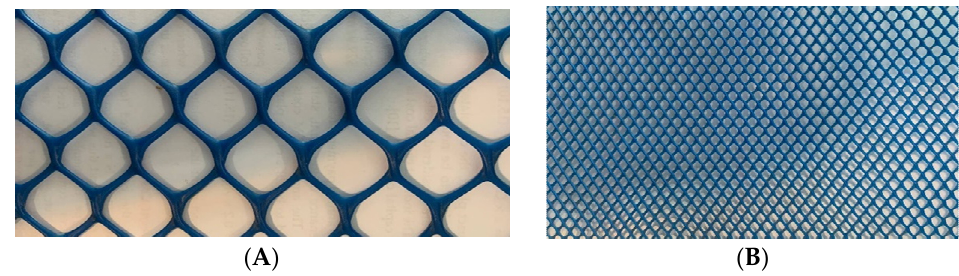
( C ) Figure 3. The plates: ( A ) channel plate, ( B ) membrane plate; ( C ) the schematic with its dimensions. The membrane is supported by a plastic net spacer. In addition, the net spacer pro- motes turbulence in the feed and permeate channels. In the present study, two kinds of spacers with large (spacer 1) and small (spacer 2) network layouts were used, as shown in